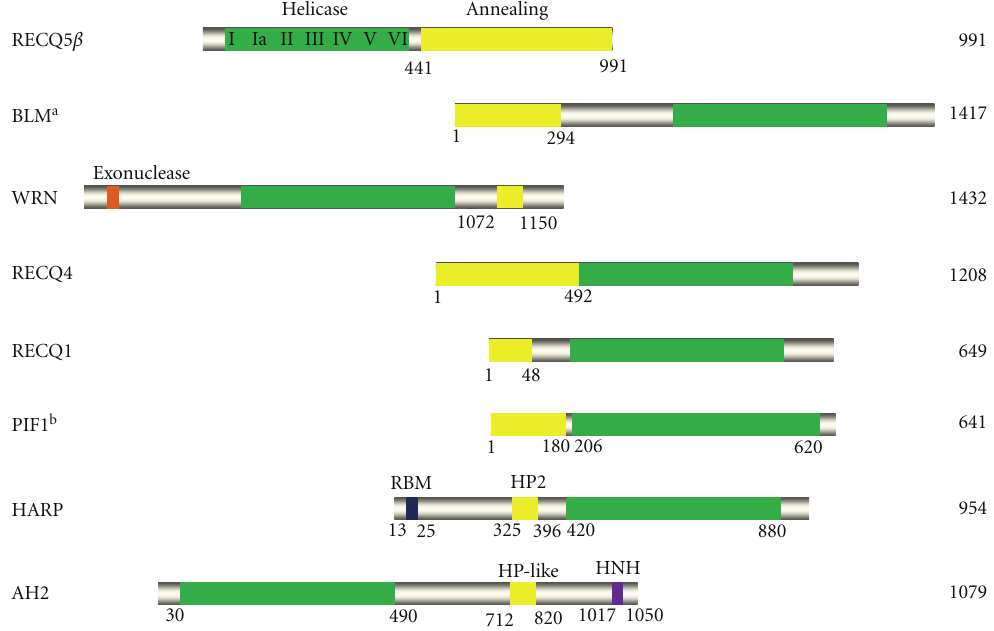
Figure 2: Alignment of human DNA helicases that contain annealing activity. The annealing domain is indicated in yellow and the conserved helicase core domain in green; the conserved seven helicase motifs and the accessory domains are indicated. HP2, HepA-related protein domain 2; RBM, RPA-binding motif; HNH refers to the three conserved His and Asn amino acid residues in the motif. The total number of amino acids in each helicase protein is shown to the right. (a) It was reported that the C-terminus of BLM is important for its strand- annealing function [51, 53]; (b) it was also reported that the helicase core domain of PIF1 has annealing activity [66]. The functional annealing activity domain for CSB, TWINKLE, and Dna2 has not been